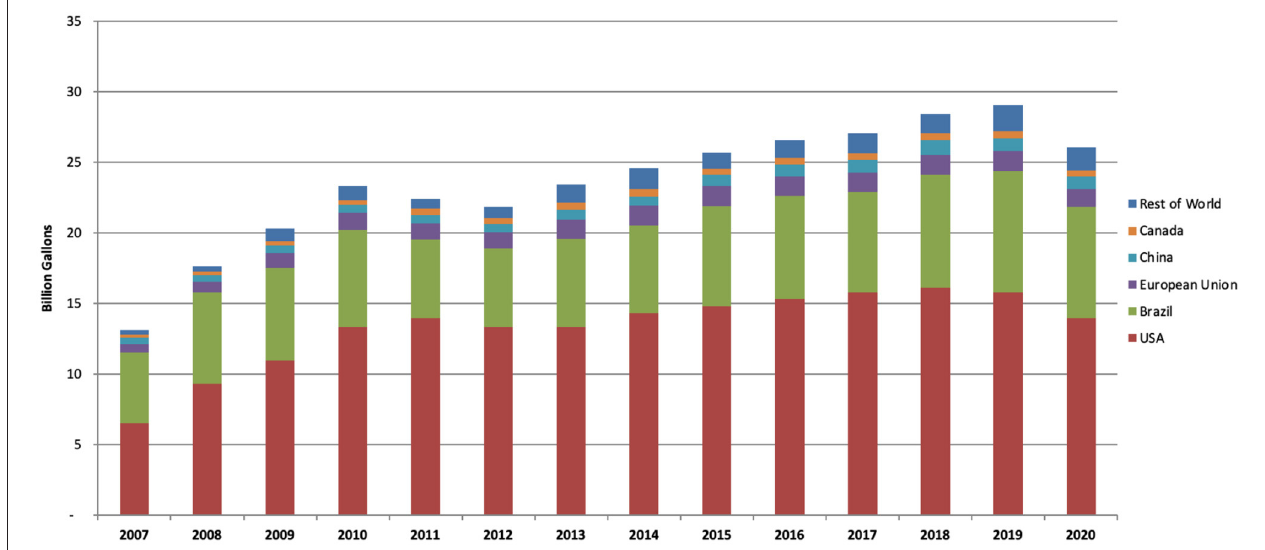
FIGURE 1 | Global ethanol production by country or region [Renewable Fuels Association (RFA)